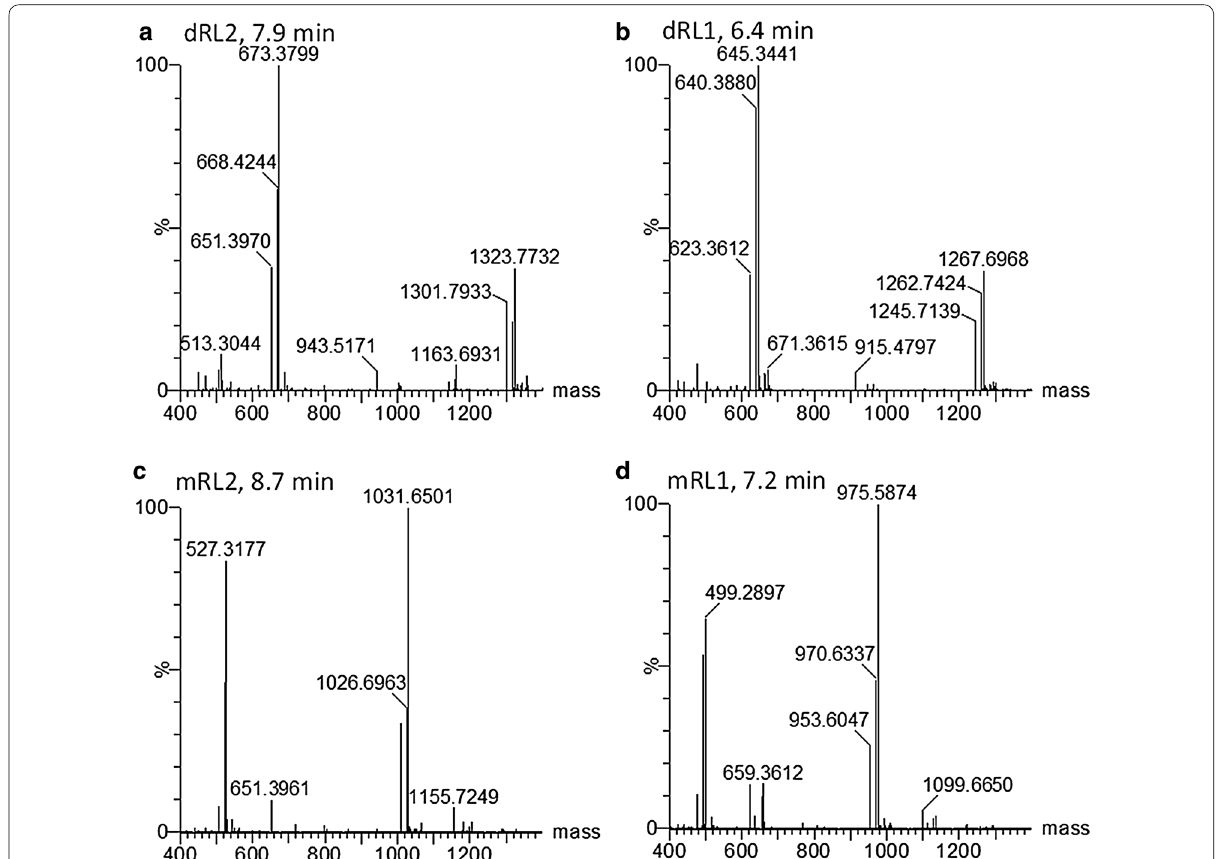
Fig. 6 Examples of the ESI–MS mass spectra of major rhamnolipid groups detected with UPLC–MS (dRL1-2 and mRL1-2). Mass spectra were gener- ated with MaxEnt 3. Refer to Table 4 for identities of dRL1-2 and mRL1-2 and expected m/z and M r